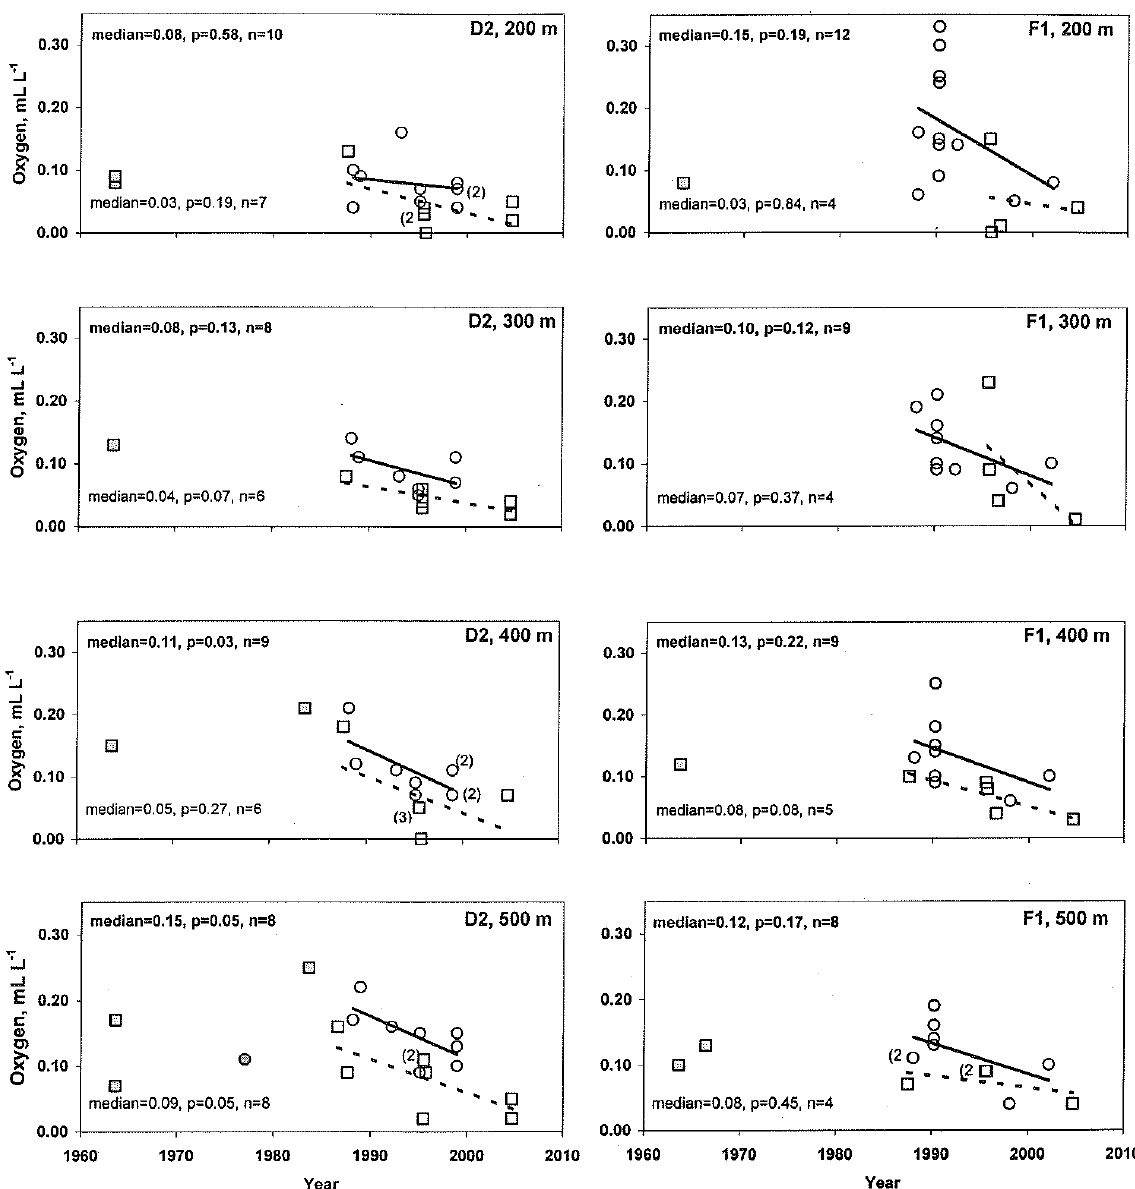
Fig. 4. Examples of regressions of oxygen observations on year for similar years with data for the NEM (circles, bold line, and text in upper part of panels) and SWM (squares, dashed line, and text in lower part of panels) for Boxes D2 and F1, chosen because two seasons were available for all depths, with medians, p for slopes, and number of values ( n ). Shaded symbols not included in